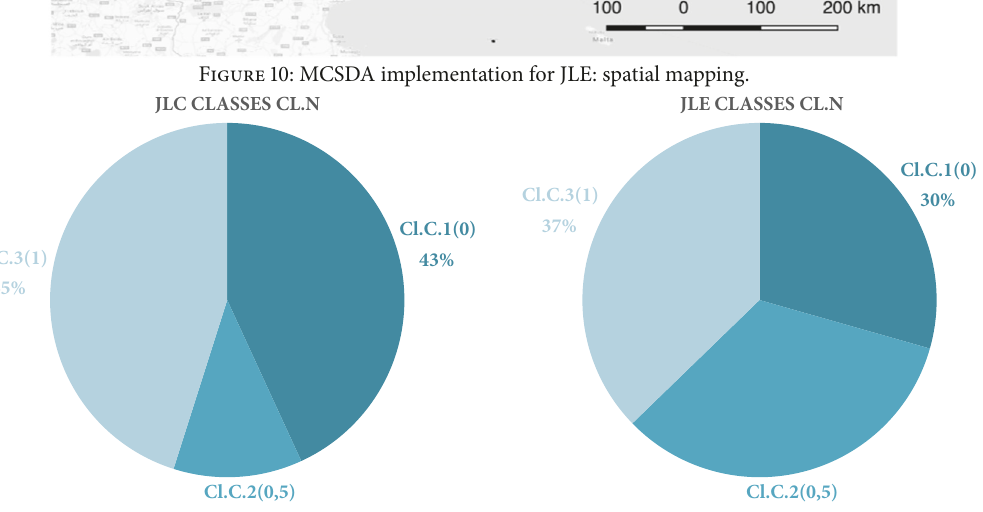
Figure 10: MCSDA implementation for JLE: spatial mapping.